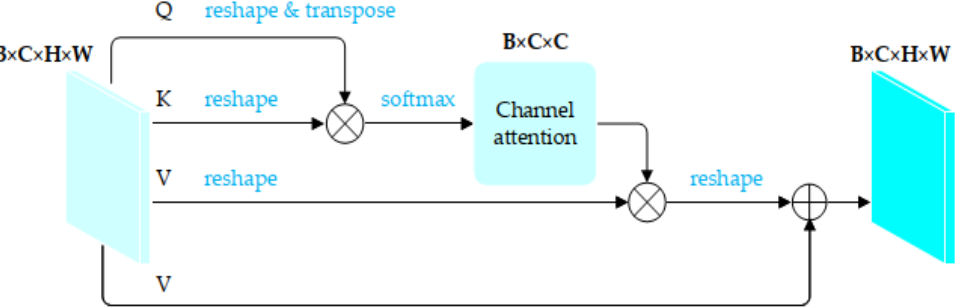
Figure 4. The structure of the CAM. Q, K, and V in the figure are Query (Q), Key (K), and Value (V), respectively, from the input feature maps. The blue fonts are the calculation process and the bold fonts indicate the feature map size in different stages.